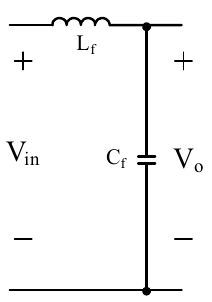
Figure 3. LC DM filter.